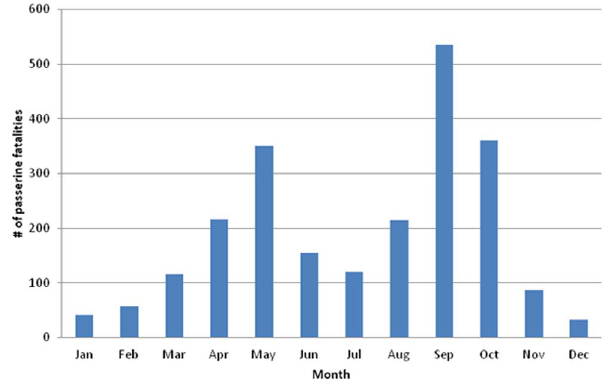
Figure 2. Monthly timing of small-passerine fatalities caused by collision with turbines and documented in 79 studies. The passerines (less than 30.5 cm in size) were included and are sorted by